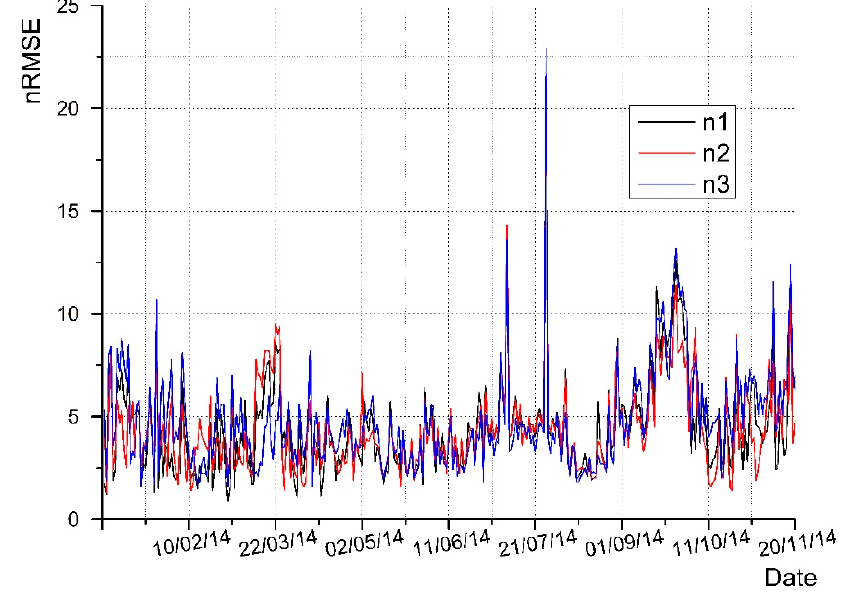
Figure 11. Comparison of n RMSE values for three ANNs during 2014.